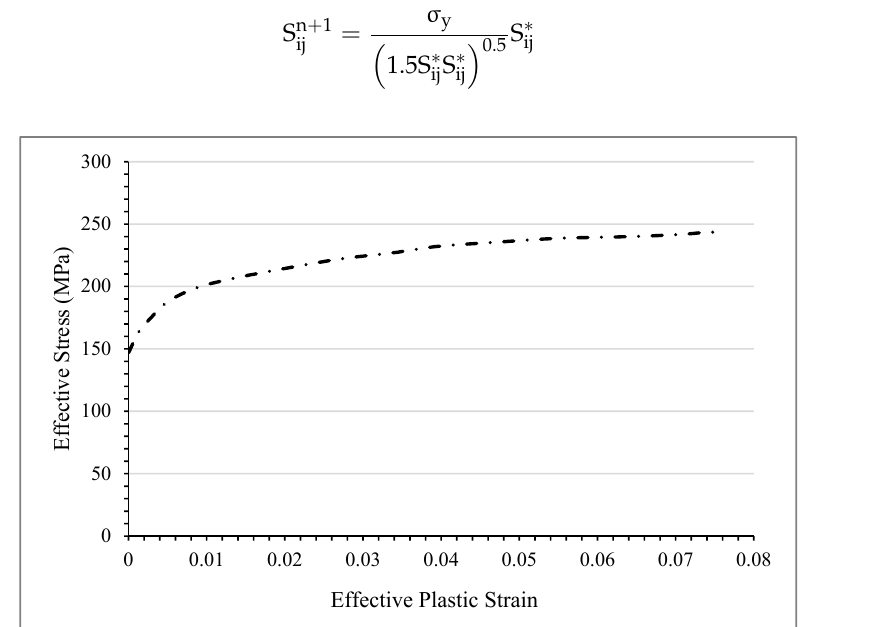
Figure 15. Effective stress-effective plastic strain curve used as input to the constitutive material model.